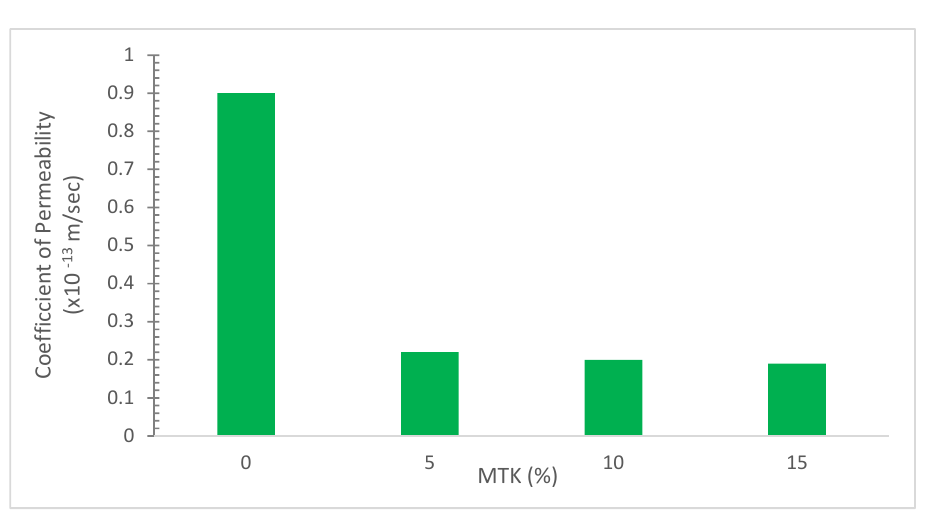
Figure 14. Permeability: data source [63].